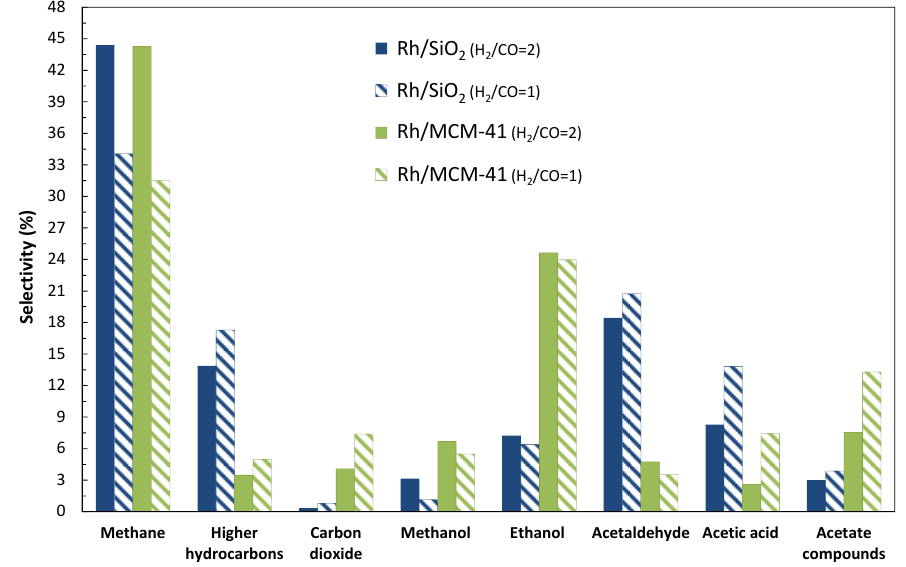
Figure 3. Comparison of the product selectivities obtained from the conversion of syngas with H 2 /CO = 2 and H 2 /CO = 1 over Rh/SiO 2 and Rh/MCM-41. Reaction conditions (syngas H 2 /CO = 1): 280 °C, 20 bar, GHSV = 6000 mL syngas /g cat ·h for Rh/SiO 2 and GHSV = 3000 mL syngas /g cat ·h for Rh/MCM-41. Reaction conditions for the experiments with syngas H 2 /CO = 2 as indicated in Figure